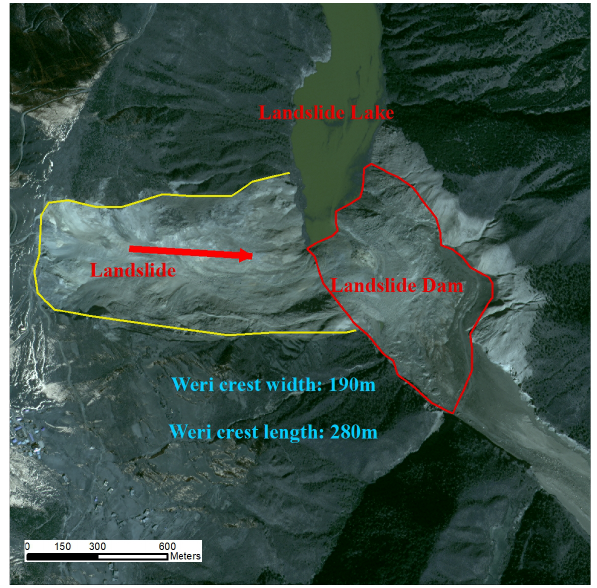
Figure 5. Landslide lake post-disaster BJ-2